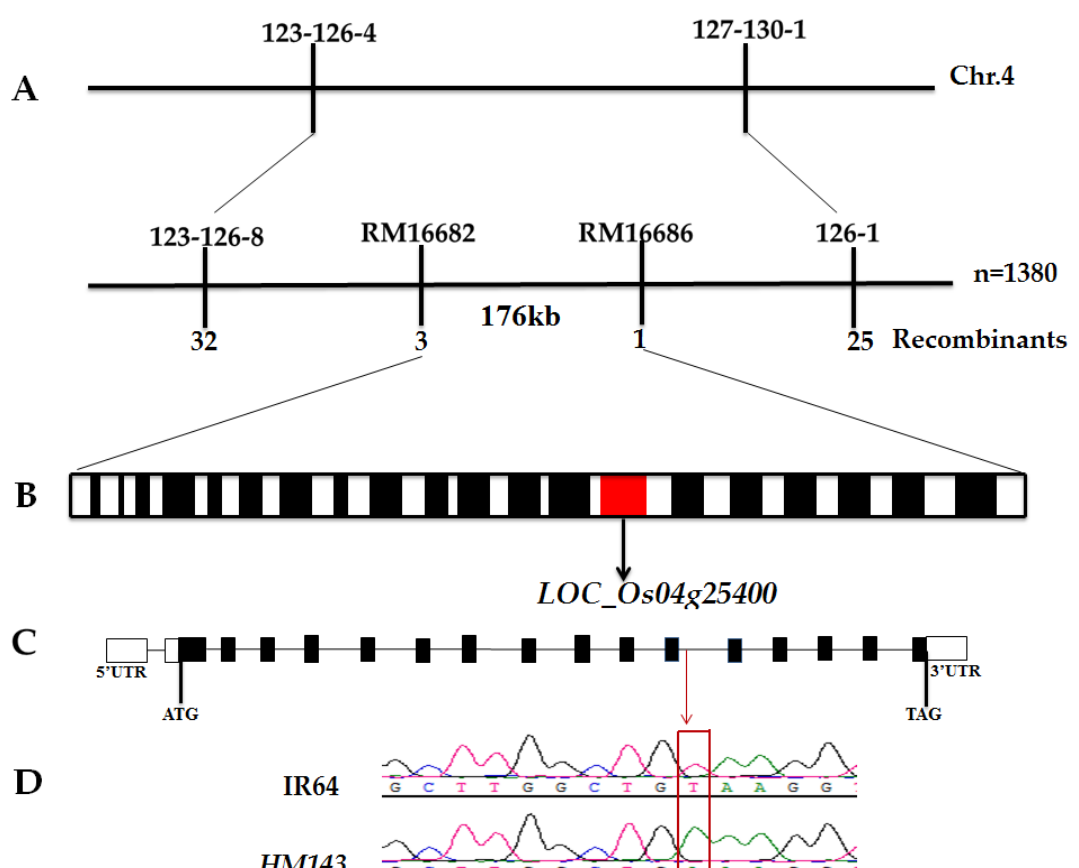
Figure 3. Map based cloning of OsHCAR . ( A ) OsHCAR gene location on chromosome 4 between markers RM16682 and RM16886. ( B ) 20 ORFs were located in 176kb region, red box represents LOC_Os04g25400 , and black boxes represent other ORFs. ( C ) Gene structure of LOC_Os04g25400 , white boxes represent 5 ′ UTR and 3 ′ UTR, respectively, while black boxes represent coding exons, lines represent introns. ( D ) Sequence analysis of the T to A point mutation in WT and HM143 on the second nucleotide of 12 th intron. Note: The numbers 123-126-4,127-130-1,123-126-8,126-1 indicate insertion/deletion markers.